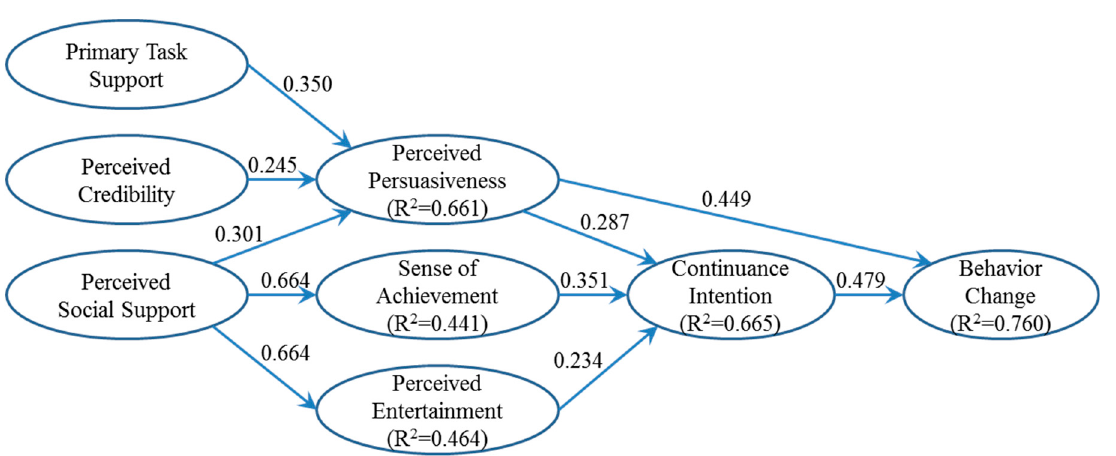
Table 4. Descriptive statistics and correlation matrix.